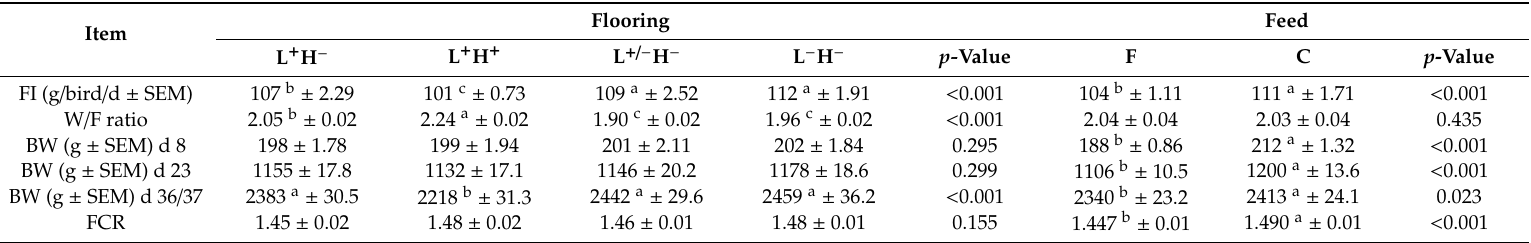
Table 8. Performance indices of broilers fed di ff erent feed particle sizes and reared on di ff erent floor designs (flooring, feed) from d 8 to d 36 / 37.